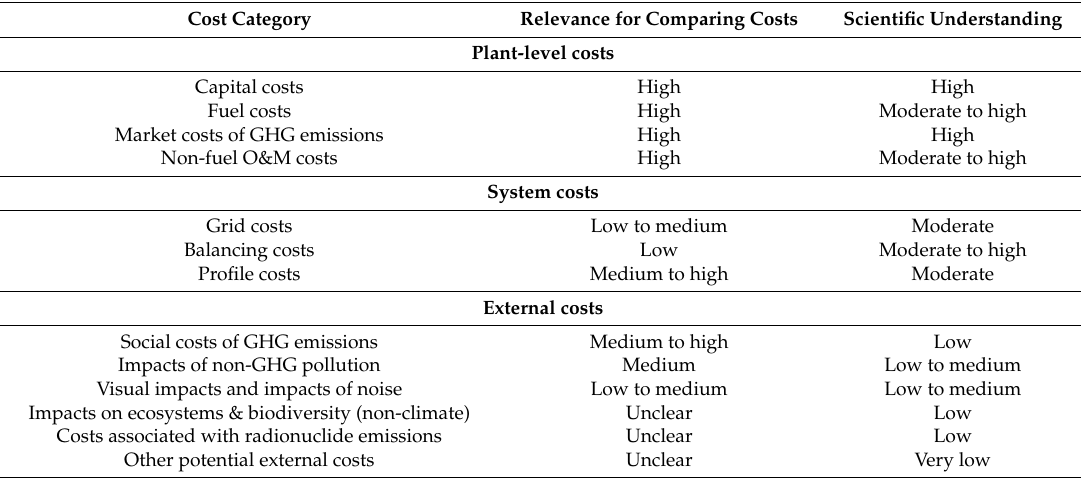
Table 16. Assessment of the relevance of individual cost categories for social cost comparisons for electricity generation technologies and of the scientific understanding of each